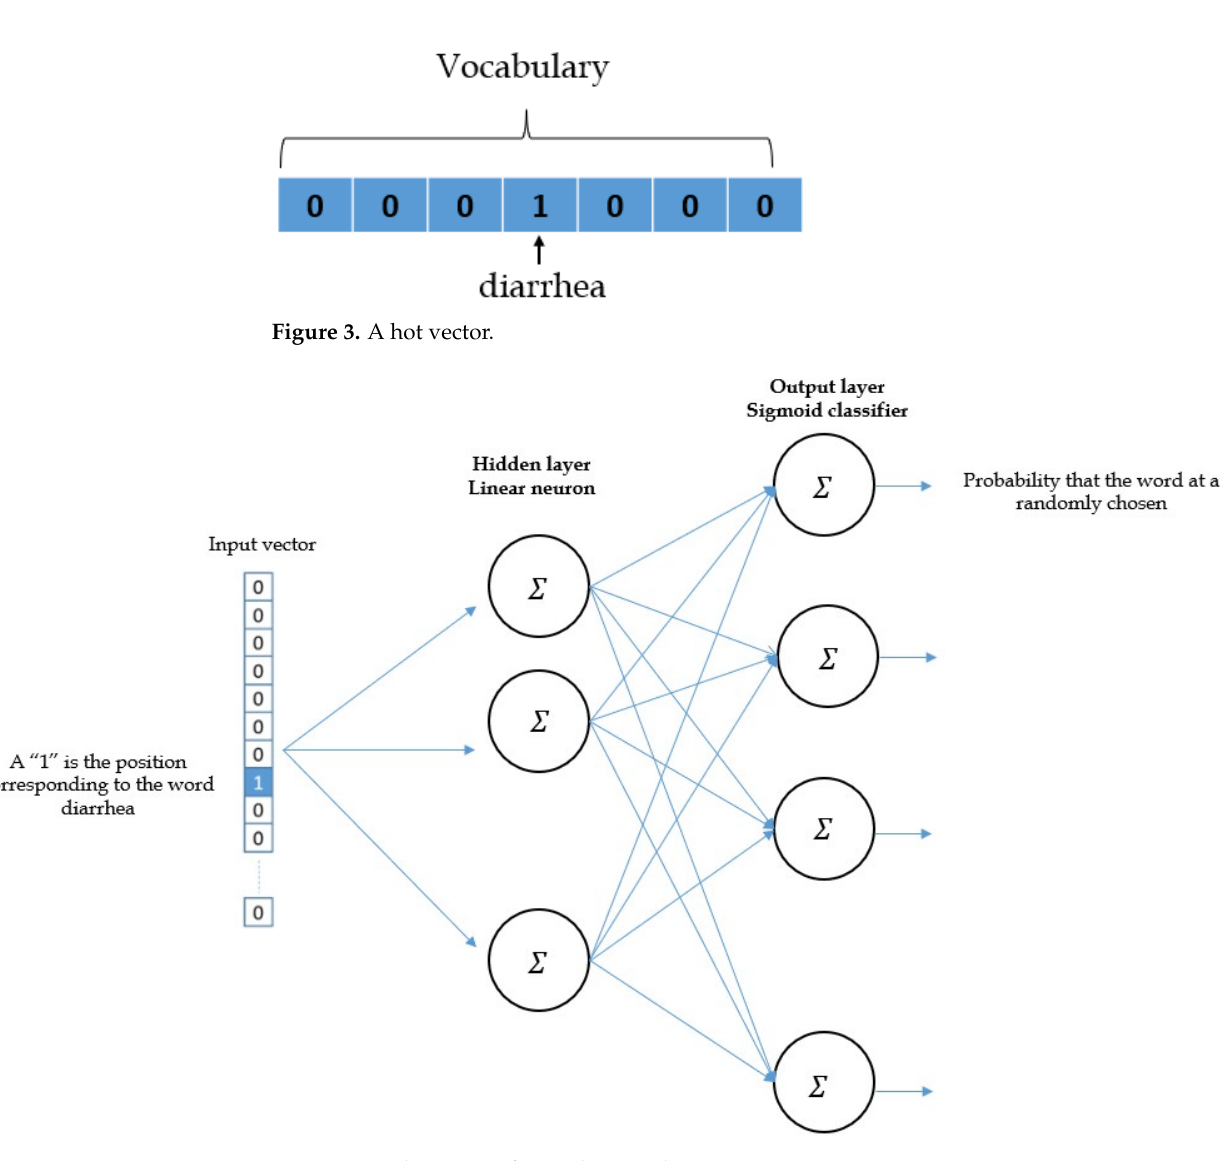
Figure 4. Architecture of neural network.